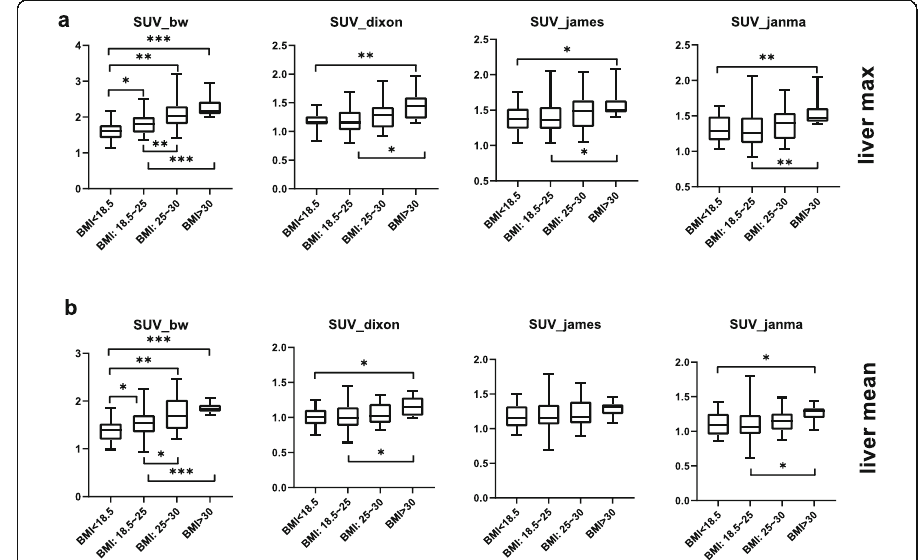
Fig. 5 Box plot showing the liver SUV distribution of underweight (BMI < 18.5), normal (BMI 18.5 – 25), overweight (BMI 25 – 30), and obese (BMI > 30) patients. *** denotes p < 0.001 in an unpaired t test, ** denotes p < 0.01, * denotes p <